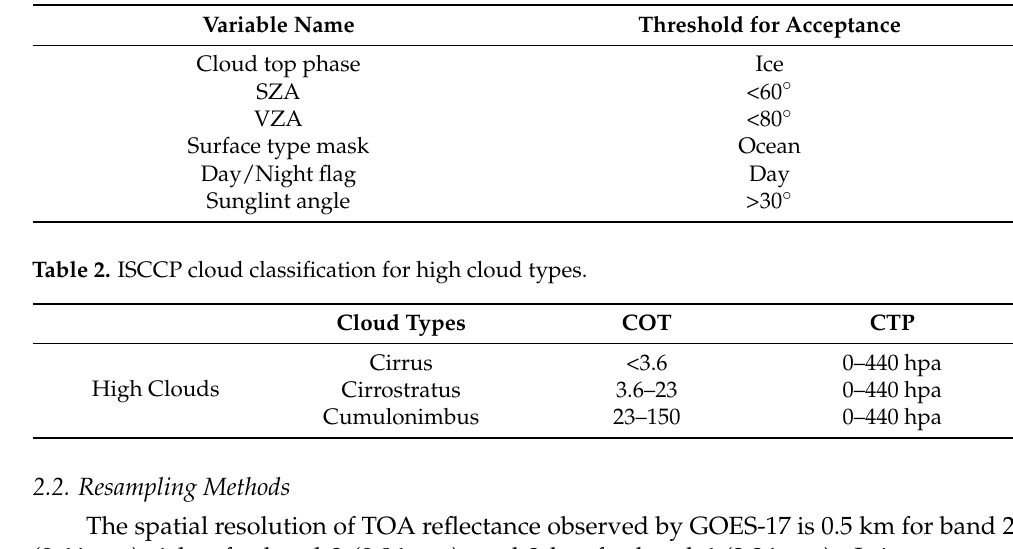
Table 1. Pixel data acceptance criteria.